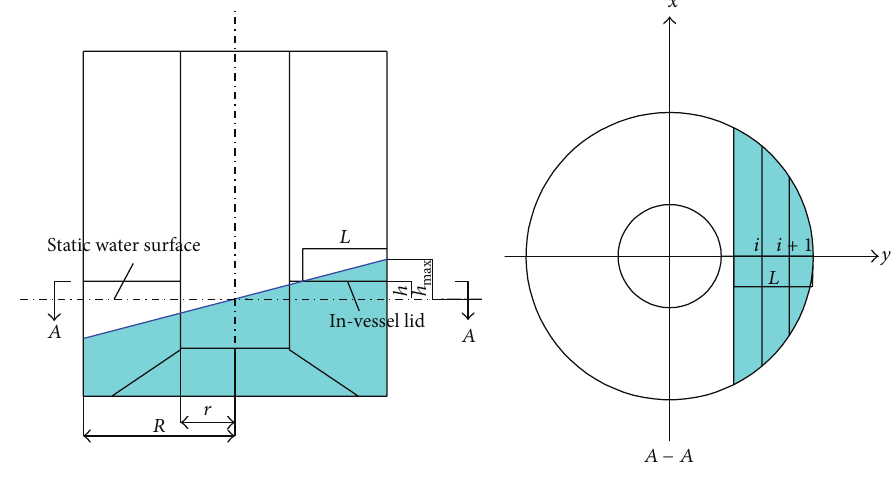
Figure 1: Schematic of